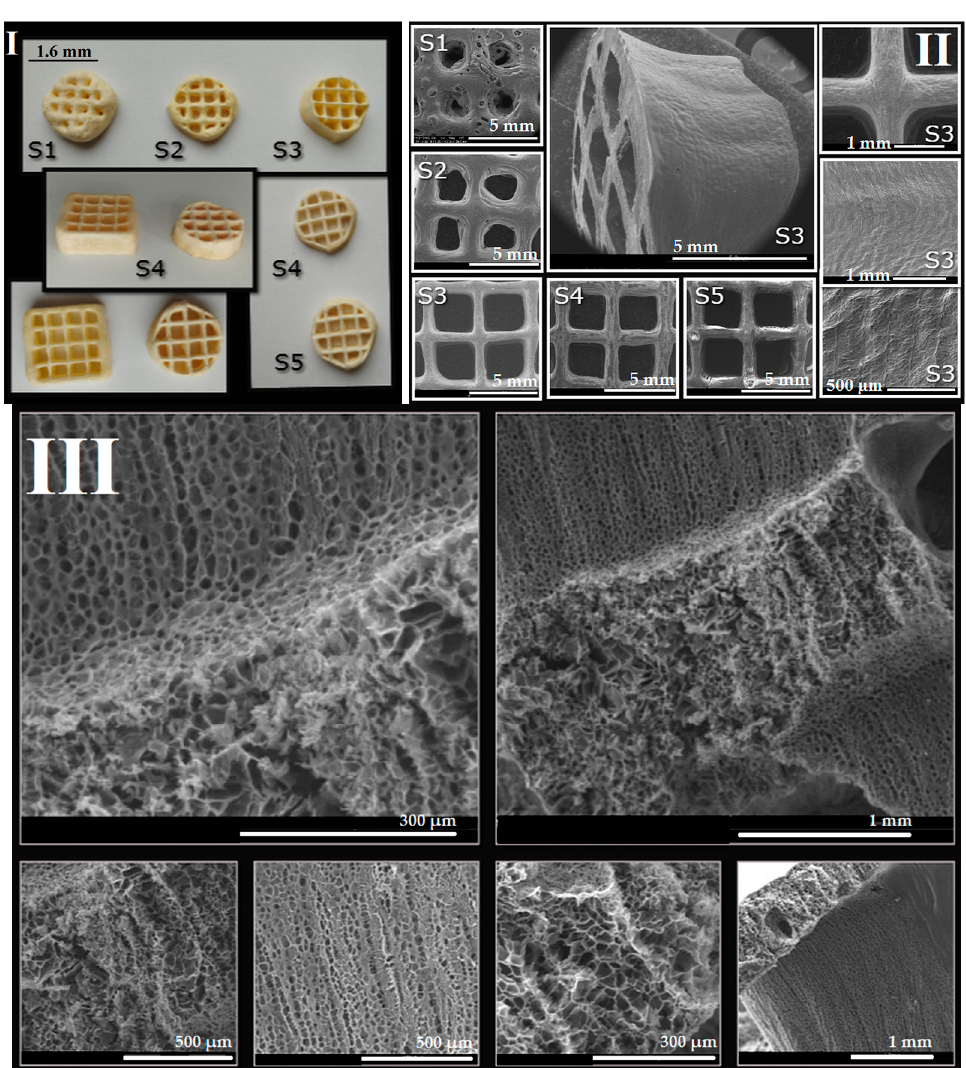
Figure 11. I. The appearance of the lyophilized 3D printed salecan-based constructs after thermocuring. II. SEM images of the 3D printed samples with an emphasis on the macropores; III. SEM images collected on the surfaces of the fractured 3D printed sample (S4).